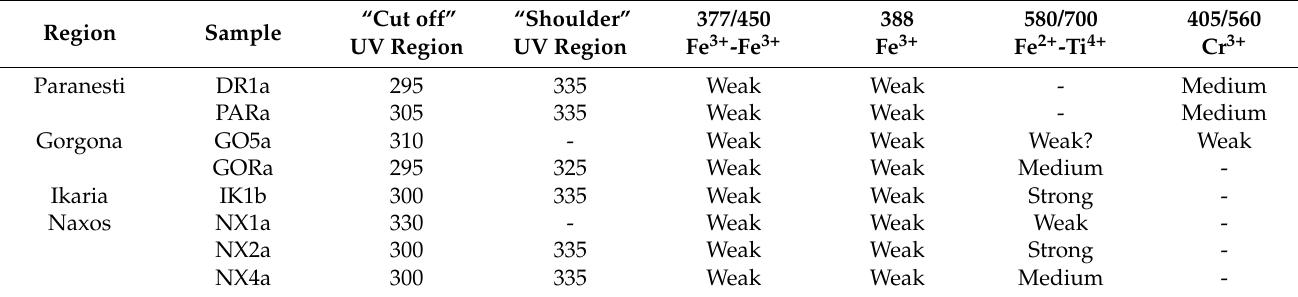
Table 4. Features and absorption peaks in nm obtained with UV-Vis spectroscopy from all studied samples.